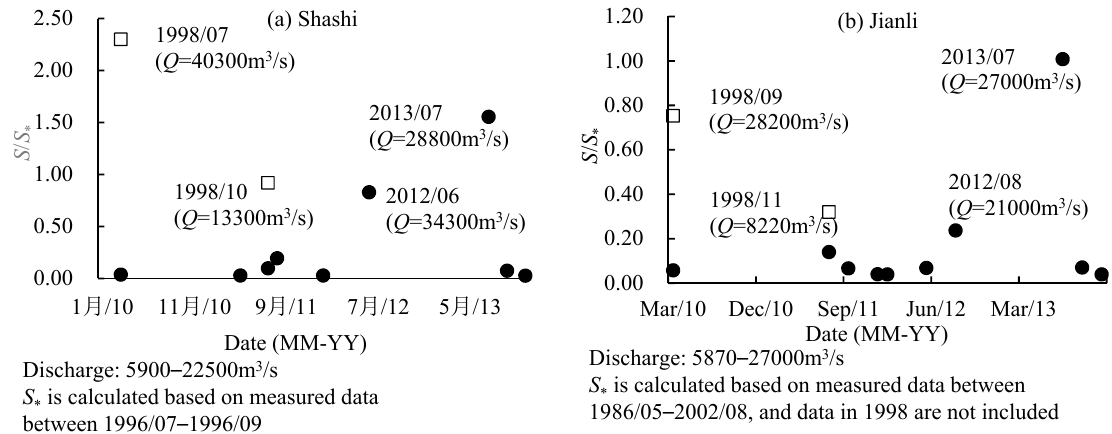
Figure 16. Sediment regimes of floods occurring before and after the operation of the TGD, the Jingjiang River Reach. ( a ) for Shashi Hydrological Station, and ( b ) for Jianli Hydrological Station, S = average concentration, and S * = average carrying capacity.